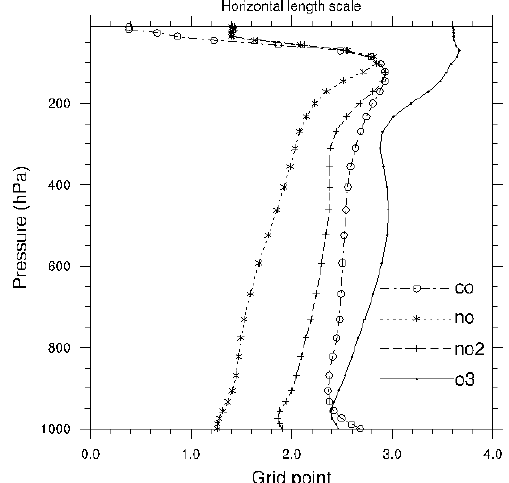
Figure 20. Horizontal length scale of O 3 , NO 2 , NO, and CO (WRF- Chem, res. 36km,